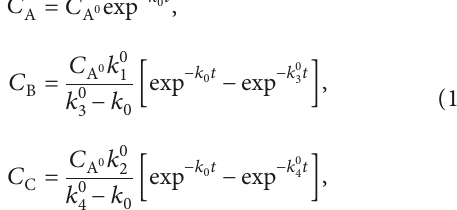
Figure 2: TEM images of the C-ATS-I